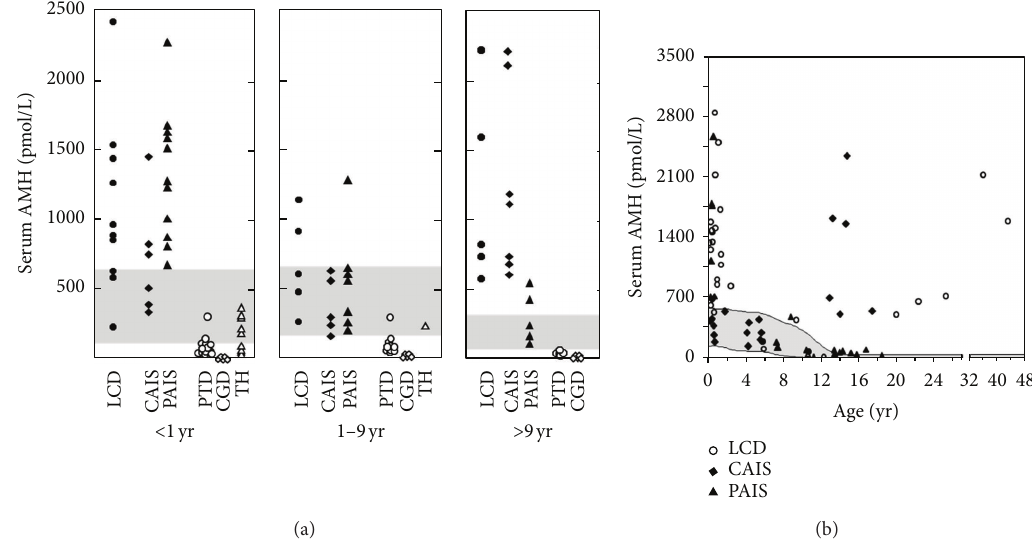
Figure 4: Serum AMH in disorders of sex development (DSD). (a) Serum AMH levels in patients with DSD. LCD: Leydig cell defects, including Leydig cell aplasia or hypoplasia and steroidogenic enzyme mutations; CAIS: complete androgen insensitivity syndrome; PAIS: partial androgen insensitivity syndrome; PTD: partial testicular dysgenesis, including asymmetrical gonadal differentiation; CGD: complete gonadal dysgenesis; TH: true hermaphroditism or ovotesticular DSD. The shaded areas represent the normal levels. Data is obtained from [41]. Copyright, The Endocrine Society, 1999. (b) Serum AMH levels in patients with DSD due to defects in androgen production (Leydig cell defects, LCD) or action (complete or partial androgen insensitivity syndrome, AIS). The shaded area represents the normal levels. Data is obtained from [44]. Copyright, The Endocrine Society, 1994, with permission.